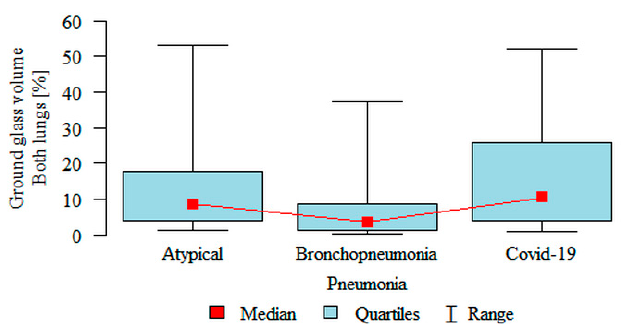
Figure 4. Comparison of the volume of “ground glass” as a percentage of the volume of both lungs, in three subgroups of pneumonia.